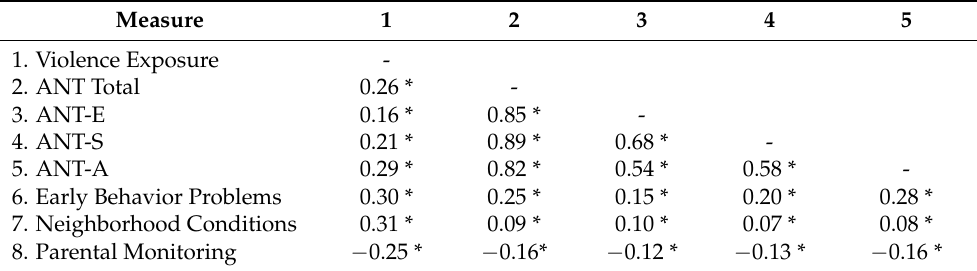
Table 2. Correlations Between Continuous